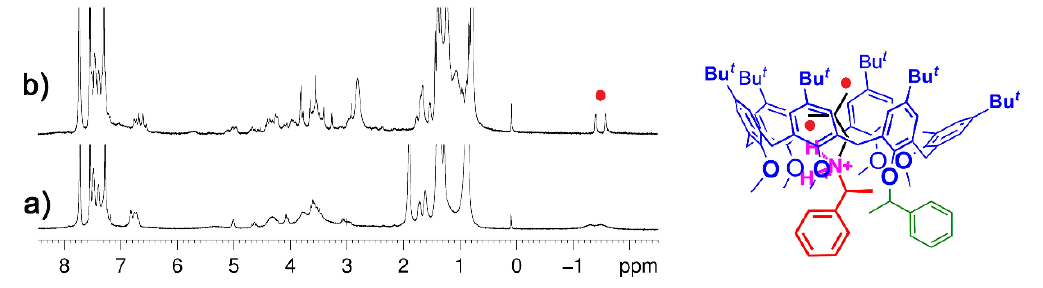
+ · − [B(Ar F ) 4 ] salt in CDCl 3